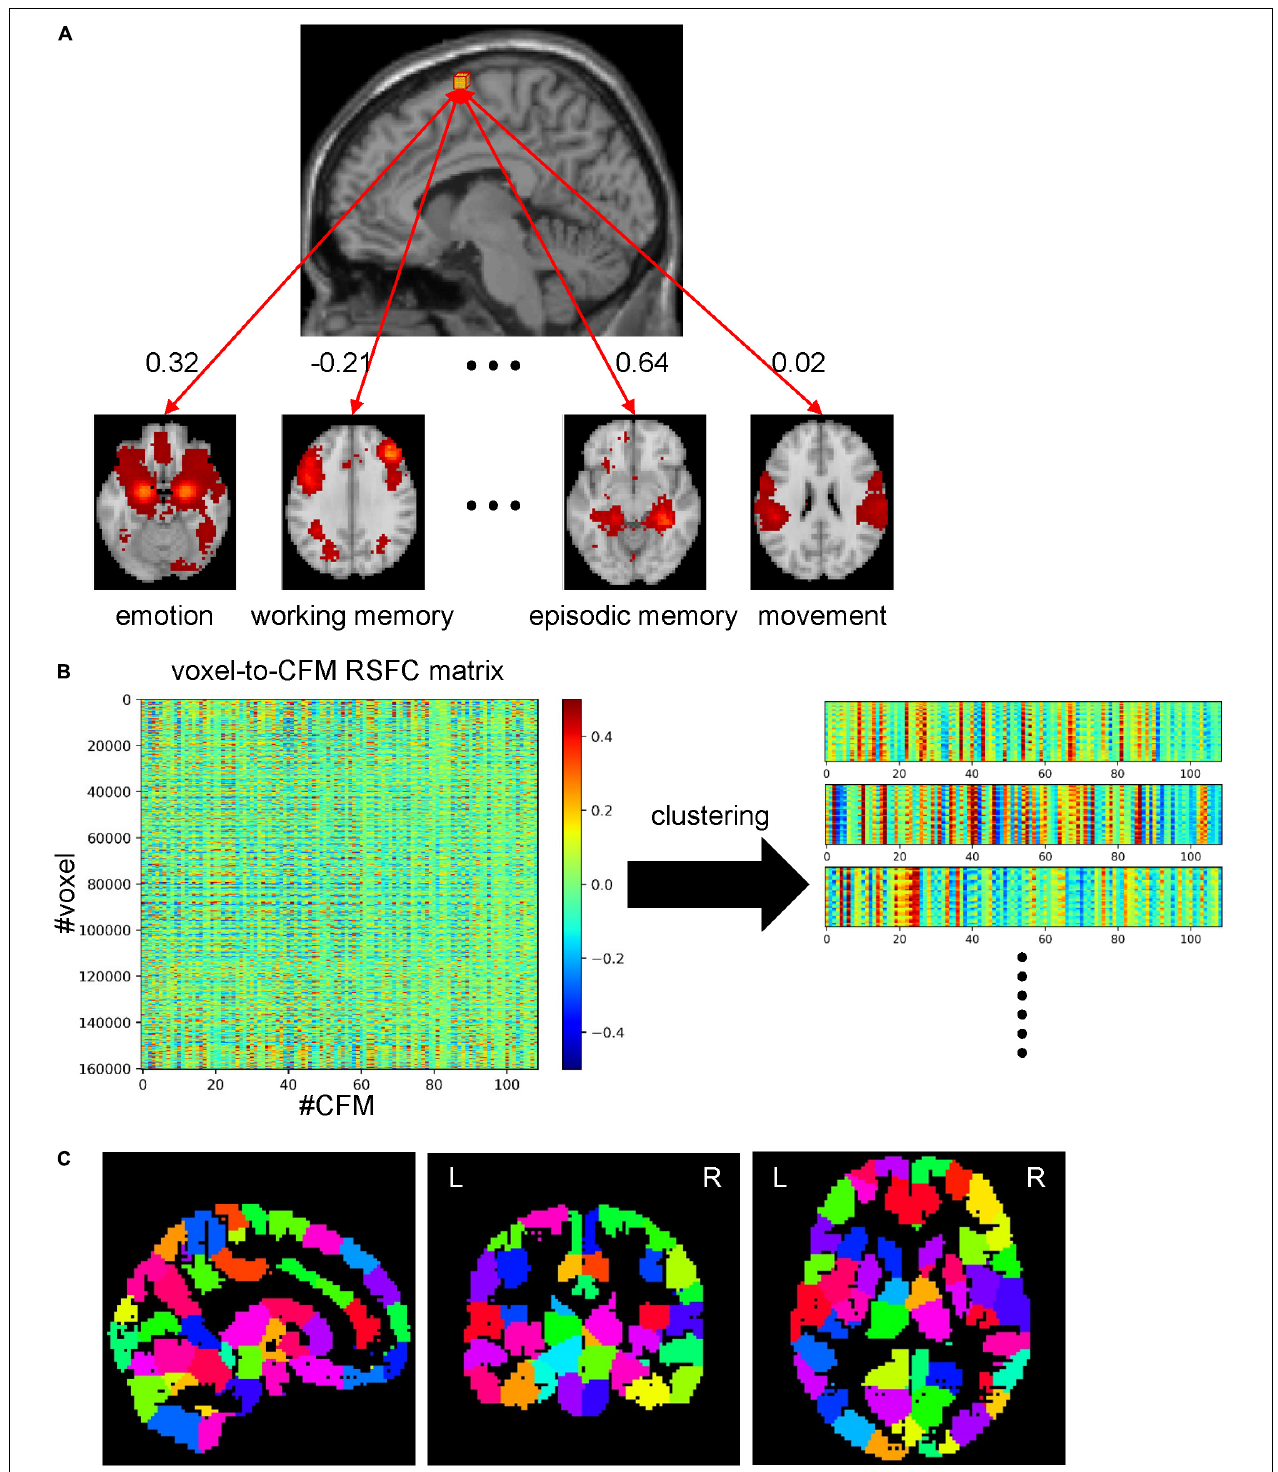
FIGURE 3 | Whole-brain parcellation based on cognitive function maps (CFMs). (A) Schematic illustration of voxel-to-CFM resting-state functional connectivities (RSFCs). A correlation coefficient between resting-state activities of each voxel and CFM was calculated, and was defined as the RSFC between them. (B) Parcellation was obtained by applying spectral clustering to the whole-brain voxel-to-CFM RSFC matrix. Each panel on the right corresponds to each resulting parcel. (C) The resulting parcellation consisting of 199 parcels.